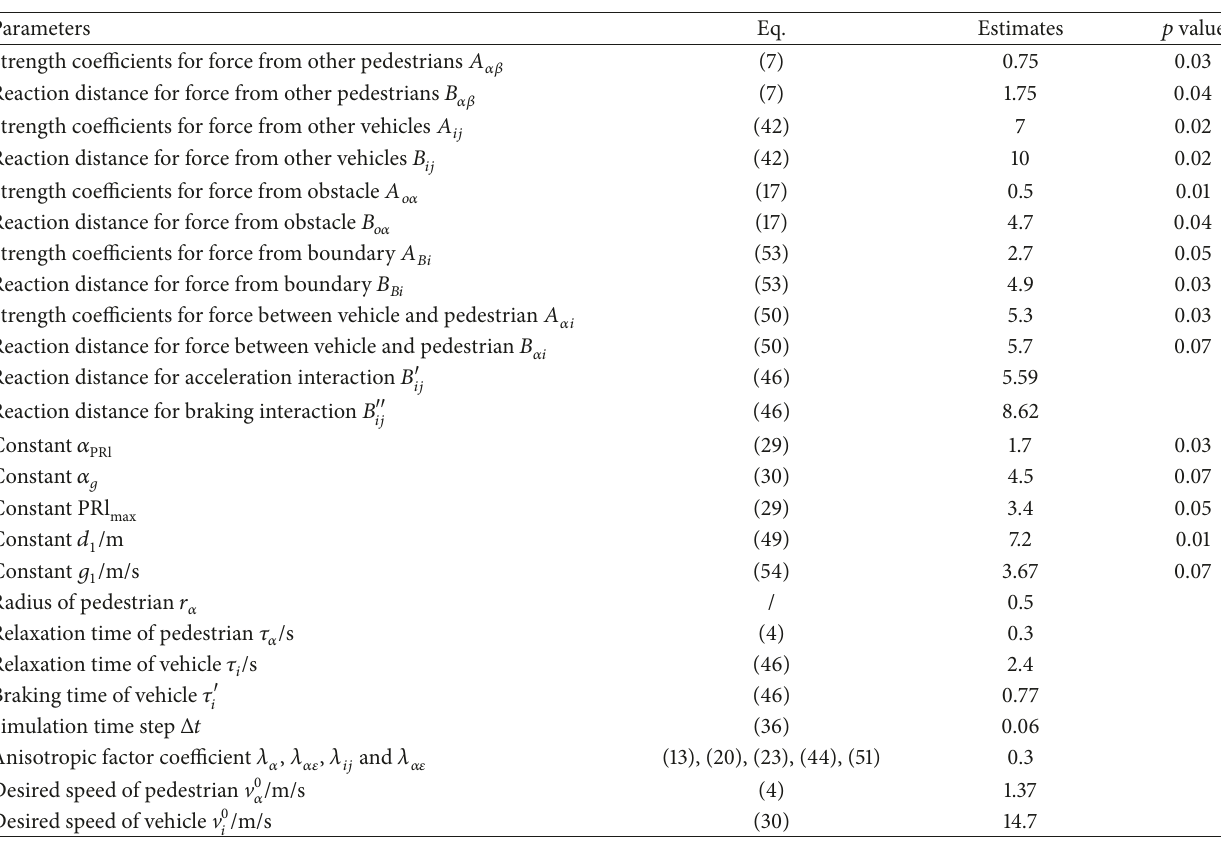
Table 1: Parameter calibration results.